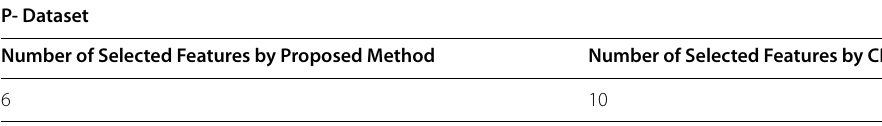
Table 20 Number of selected feature by CFS and proposed method on P- dataset P‑